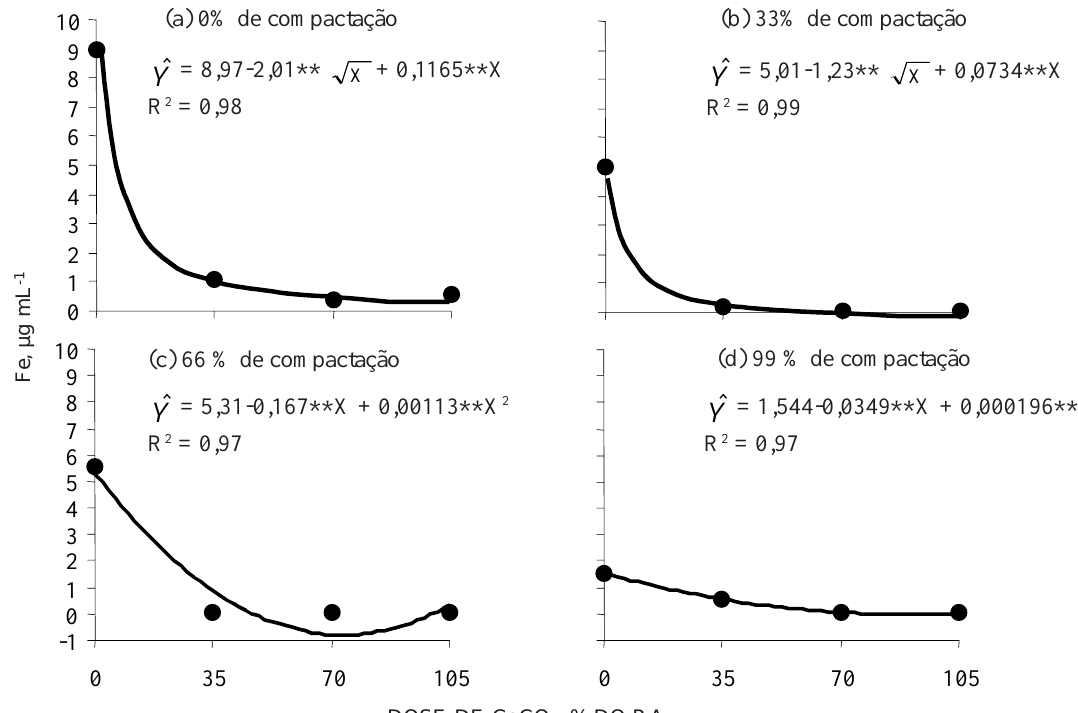
Figura 7. Teores médios de ferro nos lixiviados, considerando as doses de carbonato, dentro de cada nível de compactação. * e ** coeficientes significativos a 5 e 1%,